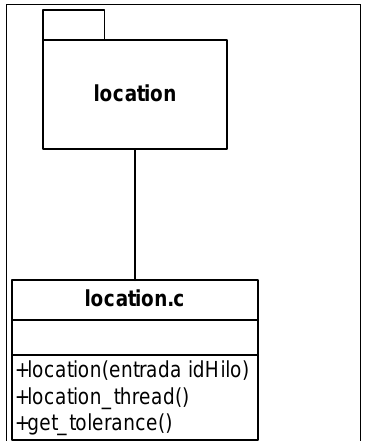
Figure 12. Class Diagram in the positioning